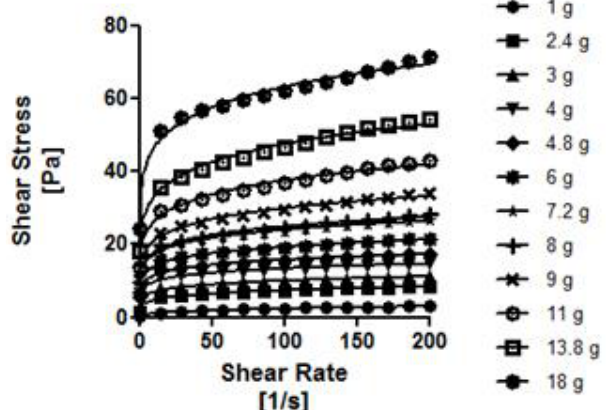
Figure 3. Flow curves at different RC concentrations in water. Solid line represents the Ostwald de Waele rheological